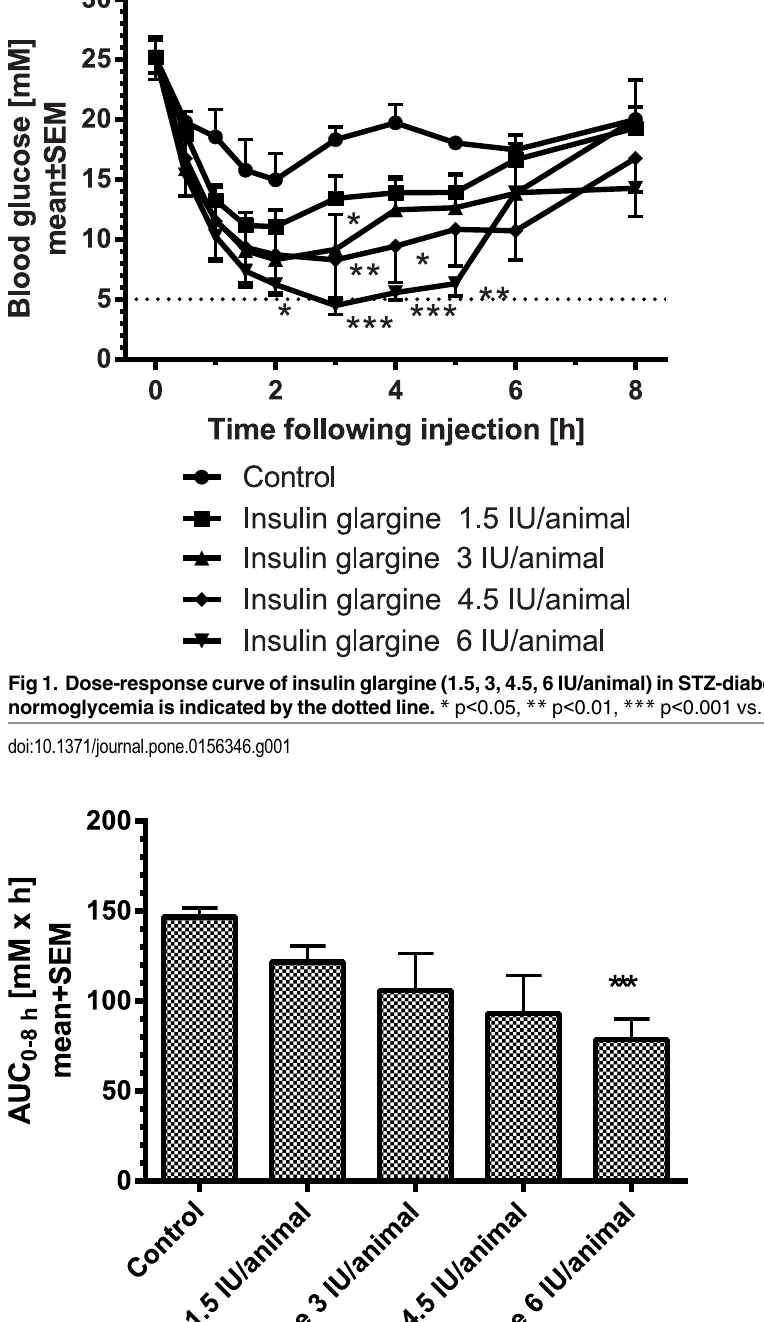
PLOS ONE | DOI:10.1371/journal.pone.0156346 June 2,